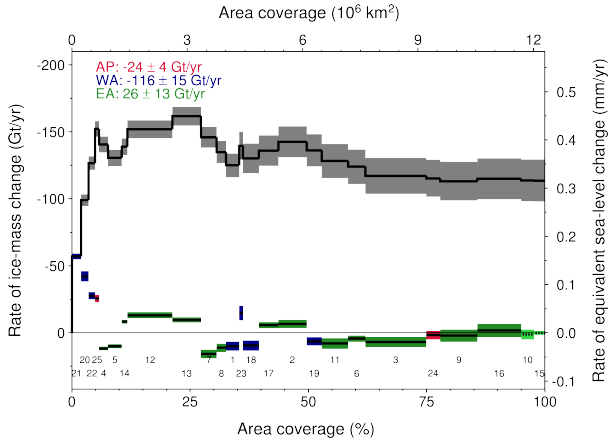
Fig. 6. Rate of basin-scale ice-mass change from GRACE (Gt/yr) for the drainage basins of the Antarctic Peninsula (red), West Antarctica (blue) and East Antarctica (green). Numbers in the bottom part of the plot refer to the drainage basins in Figure 1 and Table 2. Grey bars reflect 1-sigma uncertainties. The drainage basins are sorted according to the estimated signal-to-noise ratio of the linear trend component. GIA correction AGE1b (GRACE&GPS) applied. Statistically insignificant temporal components are indicated with a dashed lines. The cumulative sum over the basins is provided in the top part of the Figure, depicting that nearly all mass loss originates from a very small portion of the AIS.